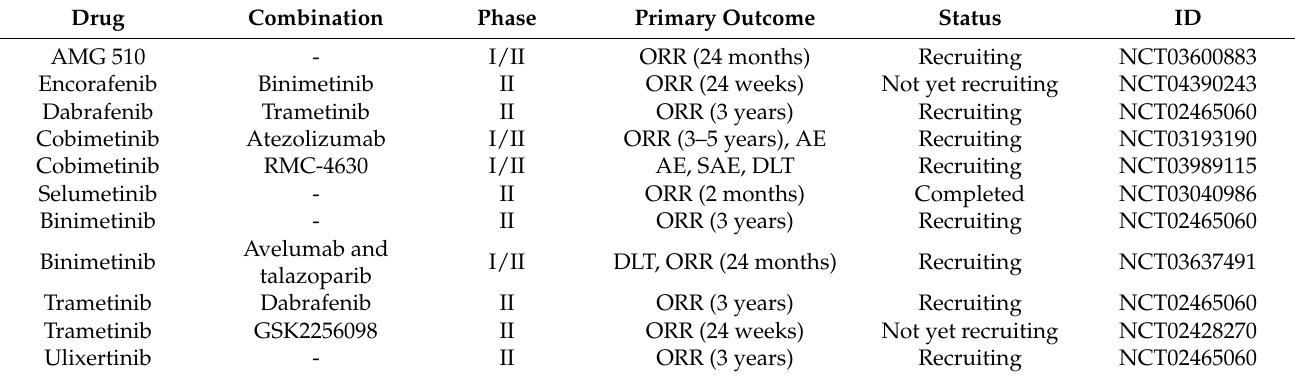
Table 7. Therapeutics targeting MAPK/ERK pathway components in ongoing clinical trials for the treatment of pancre- atic